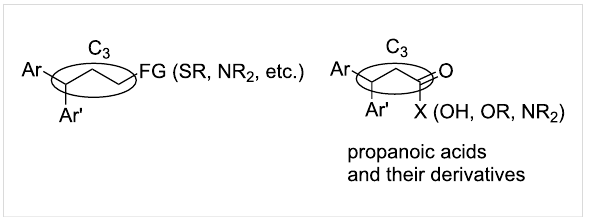
Figure 2: General structure for various biologically active compounds containing three carbon atoms, two aryl rings and functional